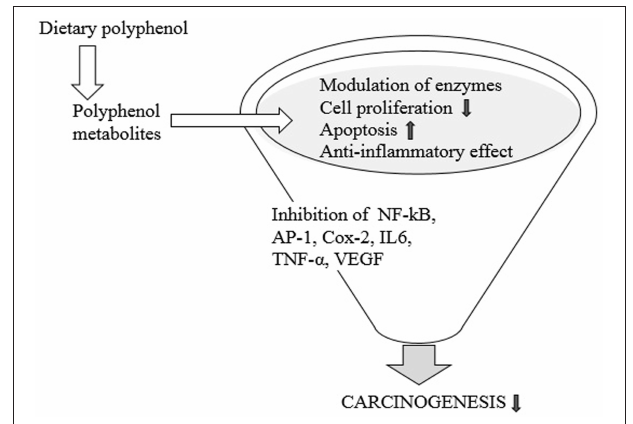
FIGURE 5 | Dietary polyphenol and carcinogenesis.